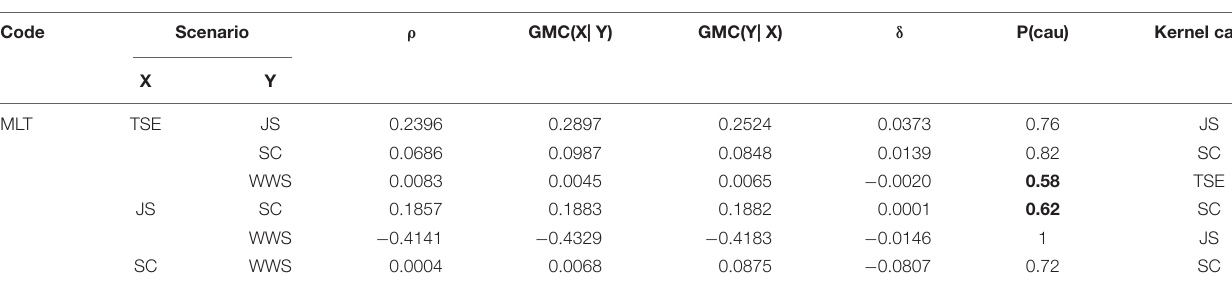
TABLE 9 | Summary of GMC for Malta.